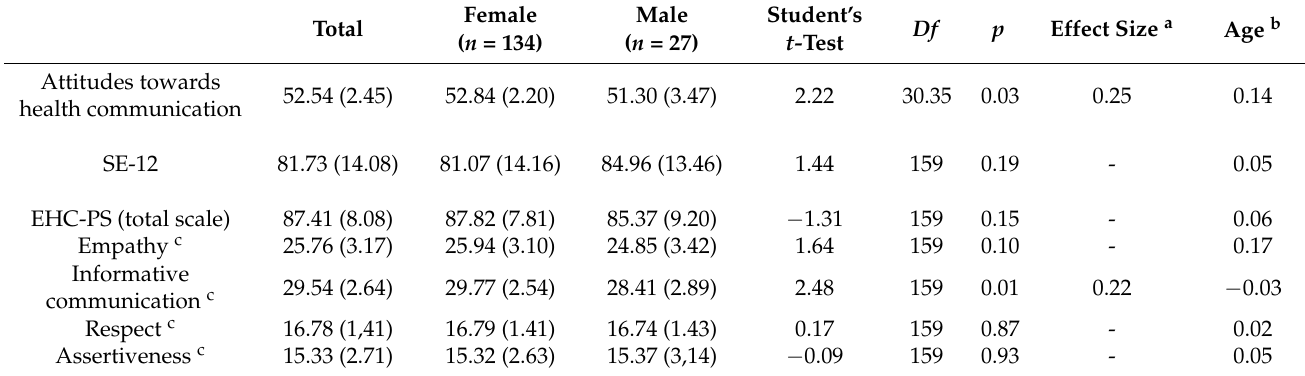
Table 3. Descriptive statistics of the main variables at baseline and differences depending on sex and age ( n = 161).